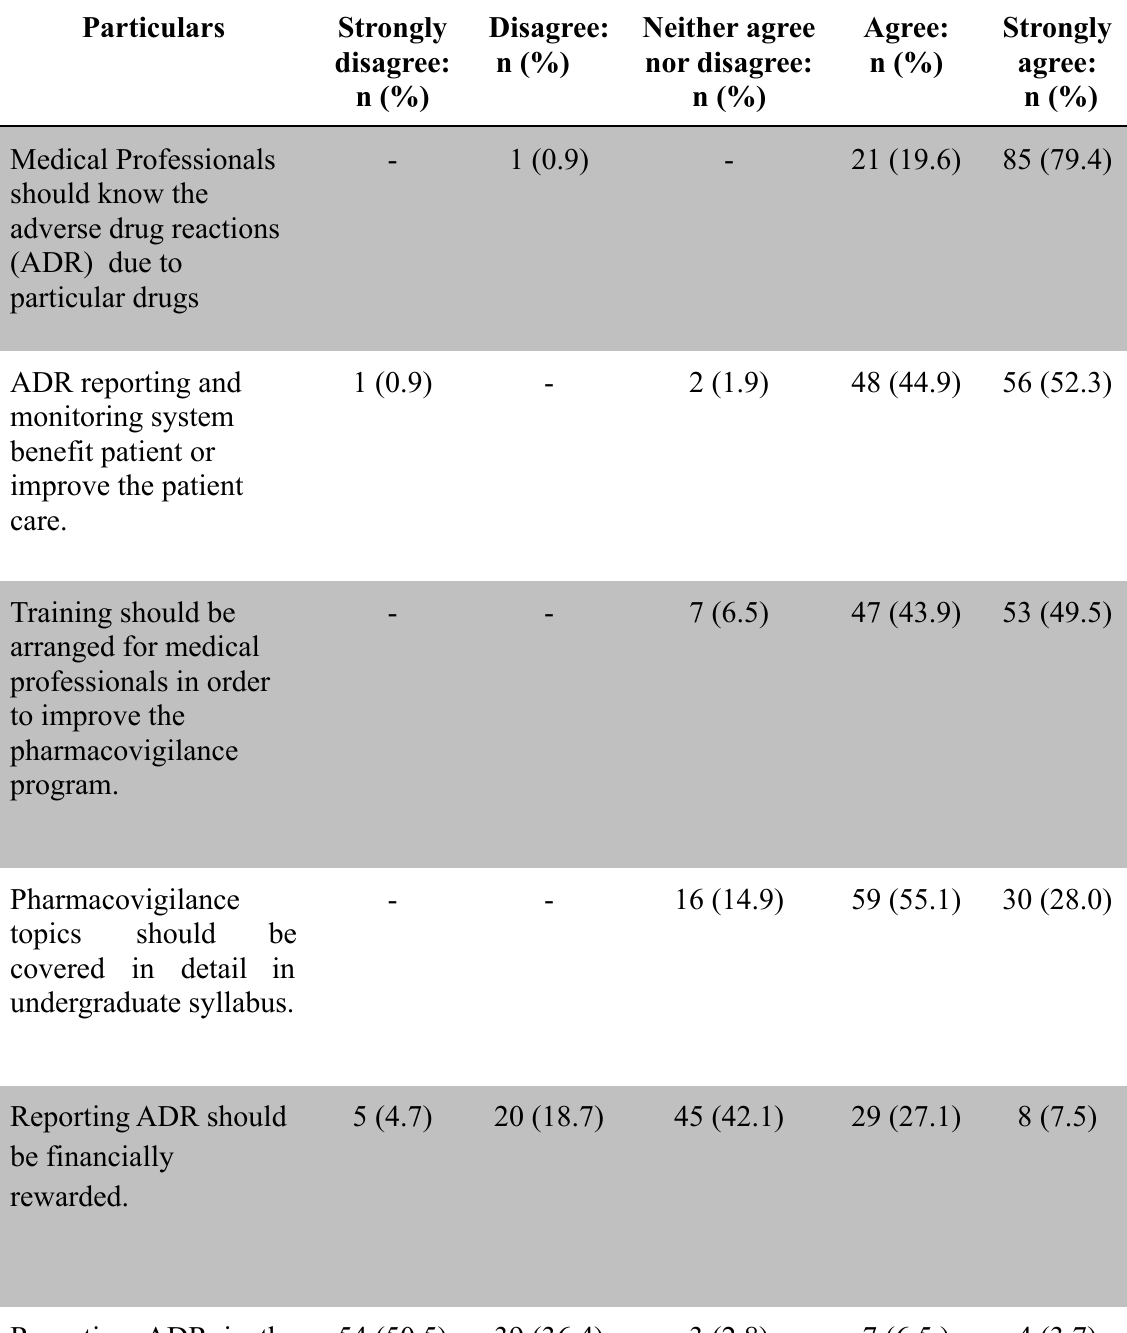
Table 2: Attitudes regarding Pharmacovigilance (N=107)